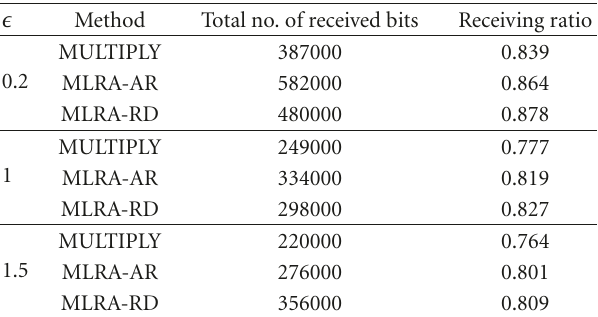
Figure 7: Cumulative distribution of receiving time. Table 3: Performance versus (cid:2) in mTreebone with varying (cid:2) . Other parameters are listed in Table